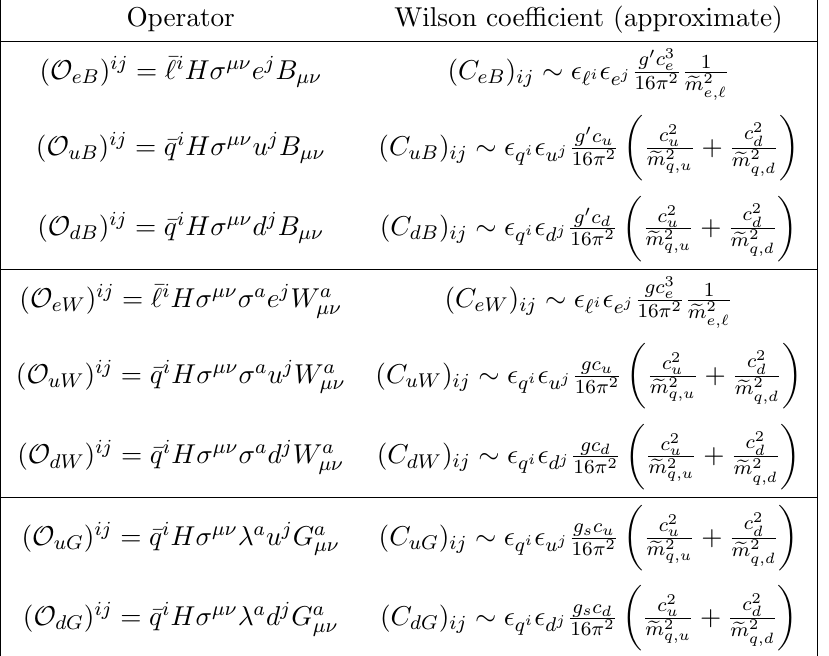
m a;b is the smaller of the e